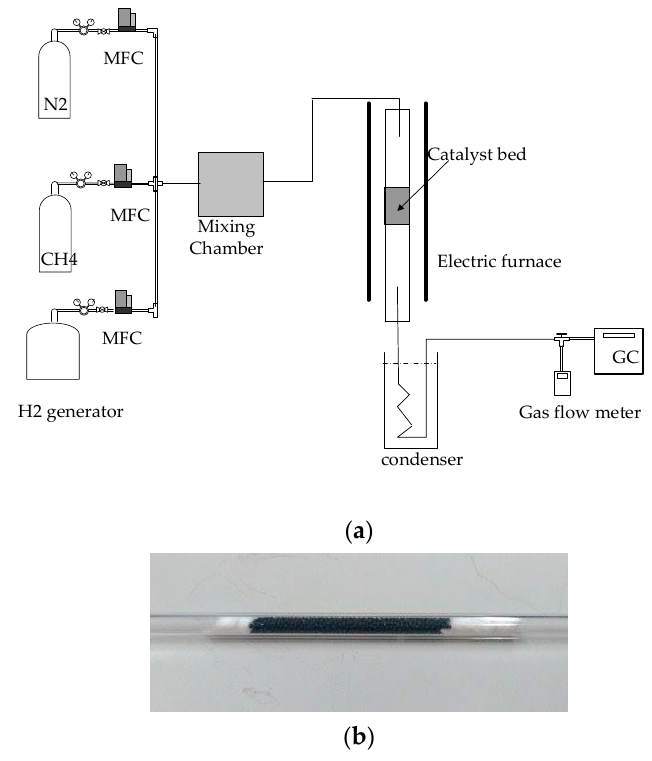
Figure 10. ( a ) Schematic of the experimental setup and ( b ) catalyst bed.